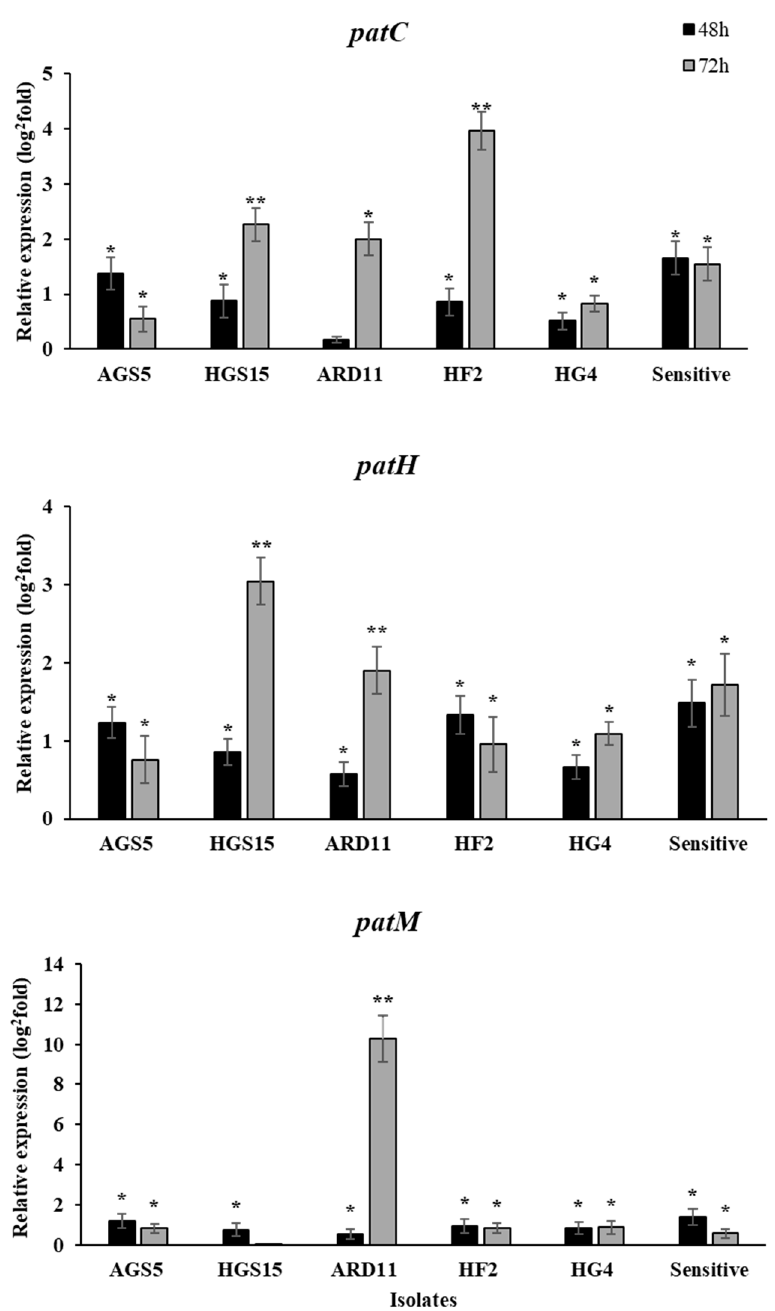
Figure 3. Expression levels of patulin biosynthesis pathway genes ( patC, patH, patM ) in Penicillium expansum isolates, grown on PDA media in the presence of fludioxonil. Expression levels were analyzed by qRT-PCR at 48 and 72 h, and the cDNA samples were standardized using mock PDA dishes at the same time points as references and normalized using the endogenous b-tubulin gene. Asterisks indicate significant differences between treatments (* means differences among the reference and ** means differences between time points) according to Tukey’s test ( p < 0.05). Vertical lines on the columns indicate the standard error of the mean.